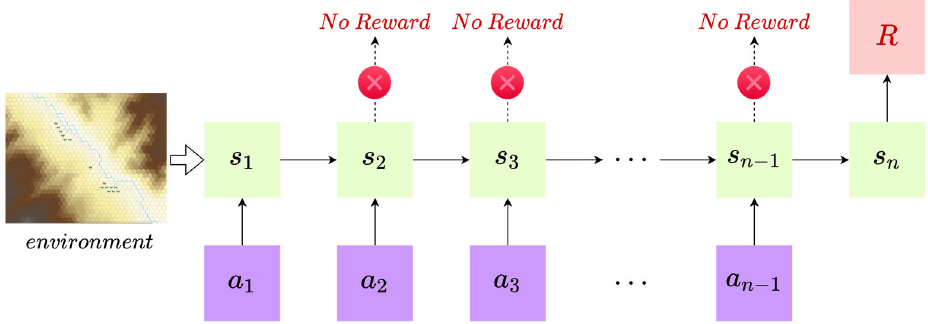
Figure 7. The reward structure of wargame without additional reward function.